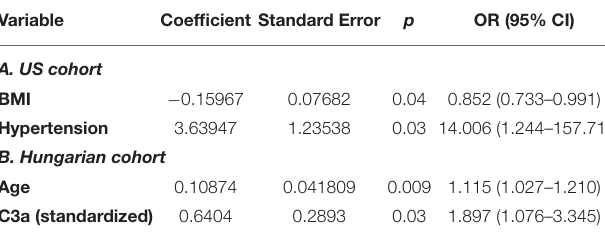
TABLE 4 | Multivariate logistic regression for development of severe AKI over course of hospitalization in the US cohort (A) and the Hungarian cohort (B). Variable Coefficient Standard Error